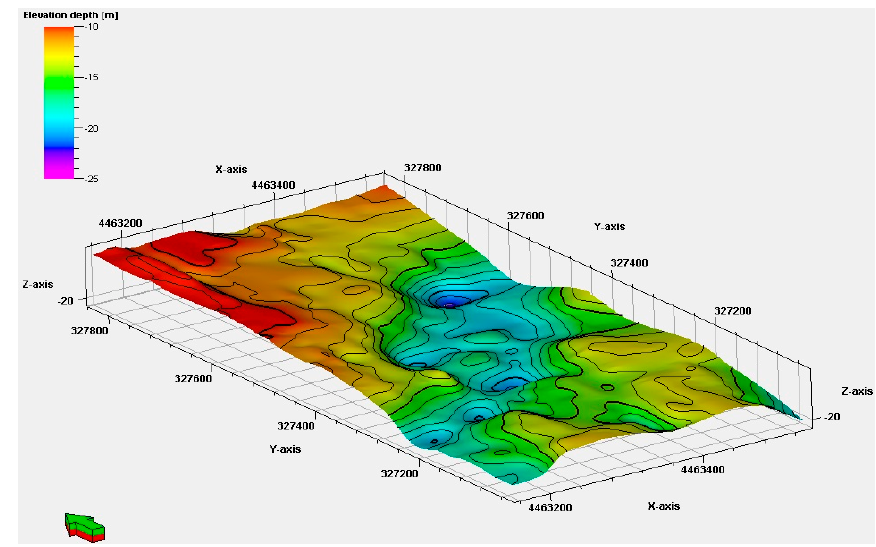
Figure 18. Structure contour map of the top of the Delavan Till. West is to the left. Contour interval = 1 m.